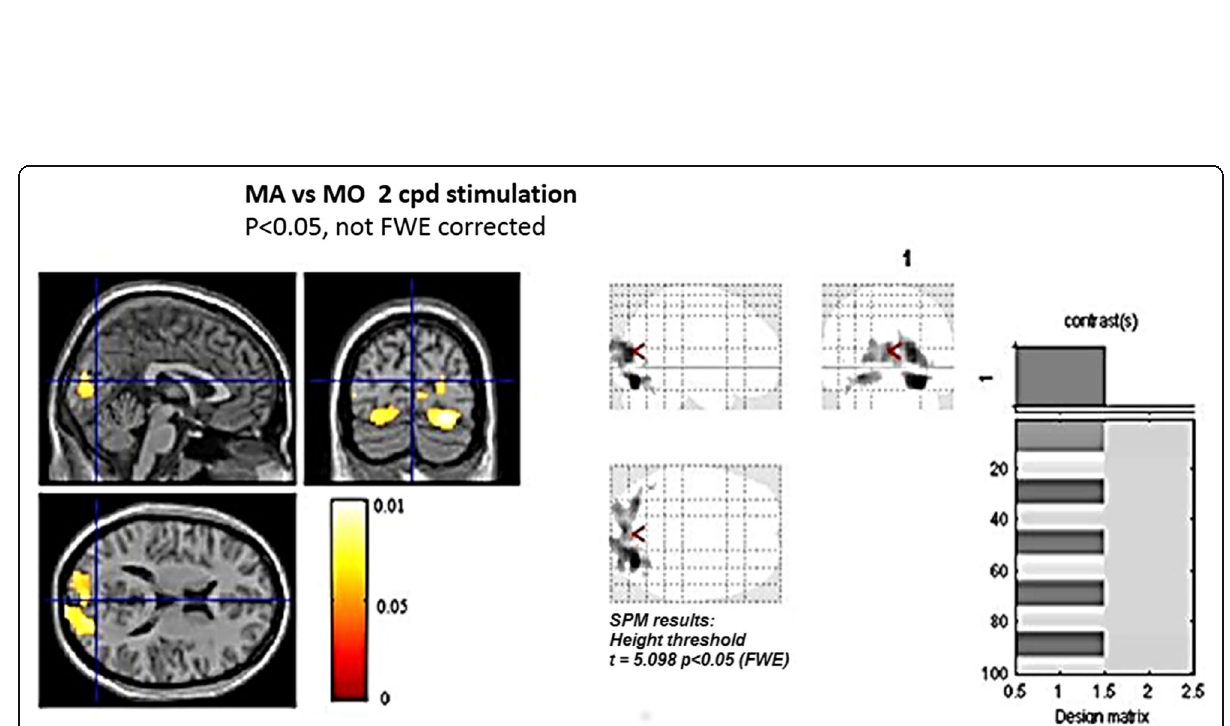
Fig. 9 Statistical probability maps reporting the comparison of bold signal changes in migraine with aura vs migraine without aura sub groups during 2 cps spatial frequency visual stimulation